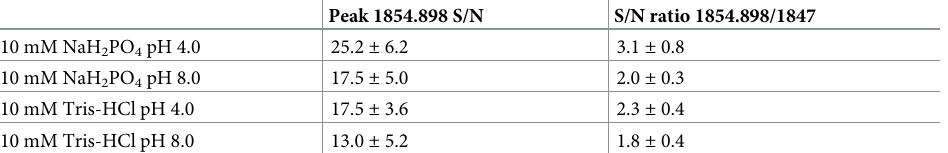
Table 2. MALDI-MS S/N data on peak m/z 1854.898 of trypsin digests of Elution fraction 3, from plasma samples, using different binding buffers.